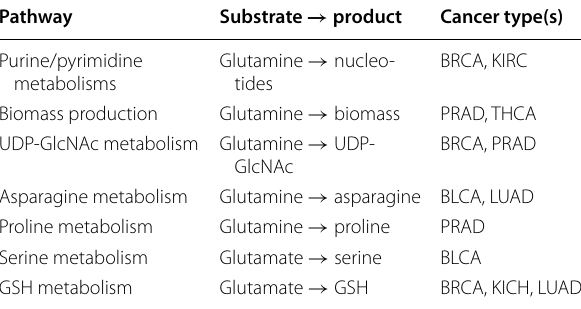
Table 3 Biological pathways with increased glutamine